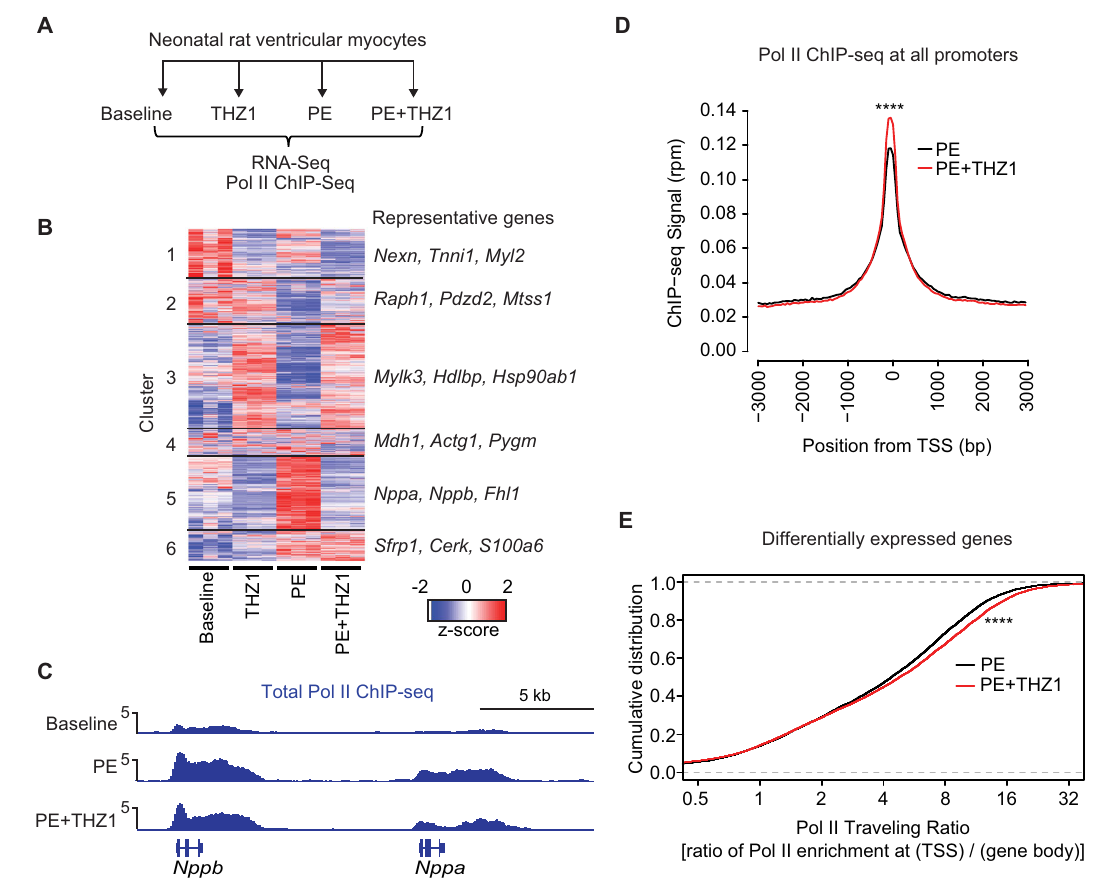
Fig. 2 THZ1 blocks stress-responsive gene programs and Pol II enrichment in cultured cardiomyocytes. A Schema of the experimental design. ChIP-seq for total Pol II was performed for 3 conditions: baseline, PE, and PE + THZ1. B A heatmap showing clustered, row-normalized global gene expression pro fi le in each sample in the indicated treatment group ( n = 3) with representative gene callouts. C Representative gene tracks of Pol II enrichment for canonical hypertrophic marker genes ( Nppb and Nppa ). D Accumulative Pol II occupancy on all promoters. E Empirical cumulative distribution plots of Pol II traveling ratios (TR) for genes that are differentially expressed in response to PE stimulation (PE vs baseline). TR is de fi ned as the ratio of (Pol II signal at TSS) / (Pol II signal at gene body). **** p < 0.0001 for indicated comparisons. Source data are provided as a Source Data fi